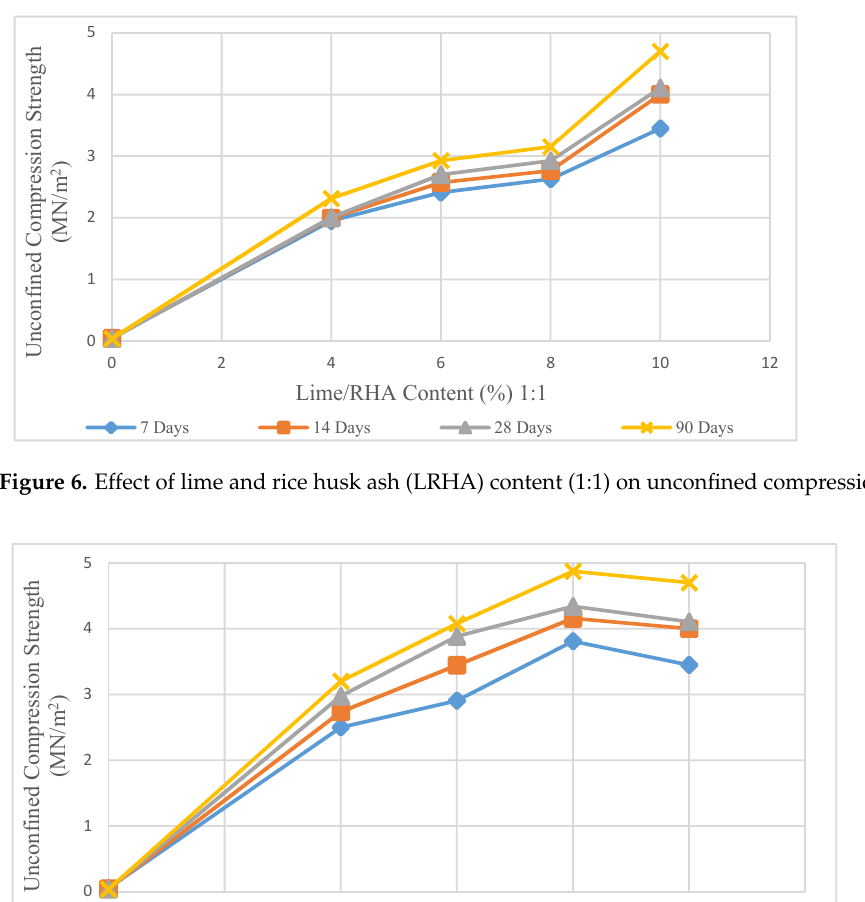
Figure 7. Effect of LRHA content (1:2) on unconfined compression strength.